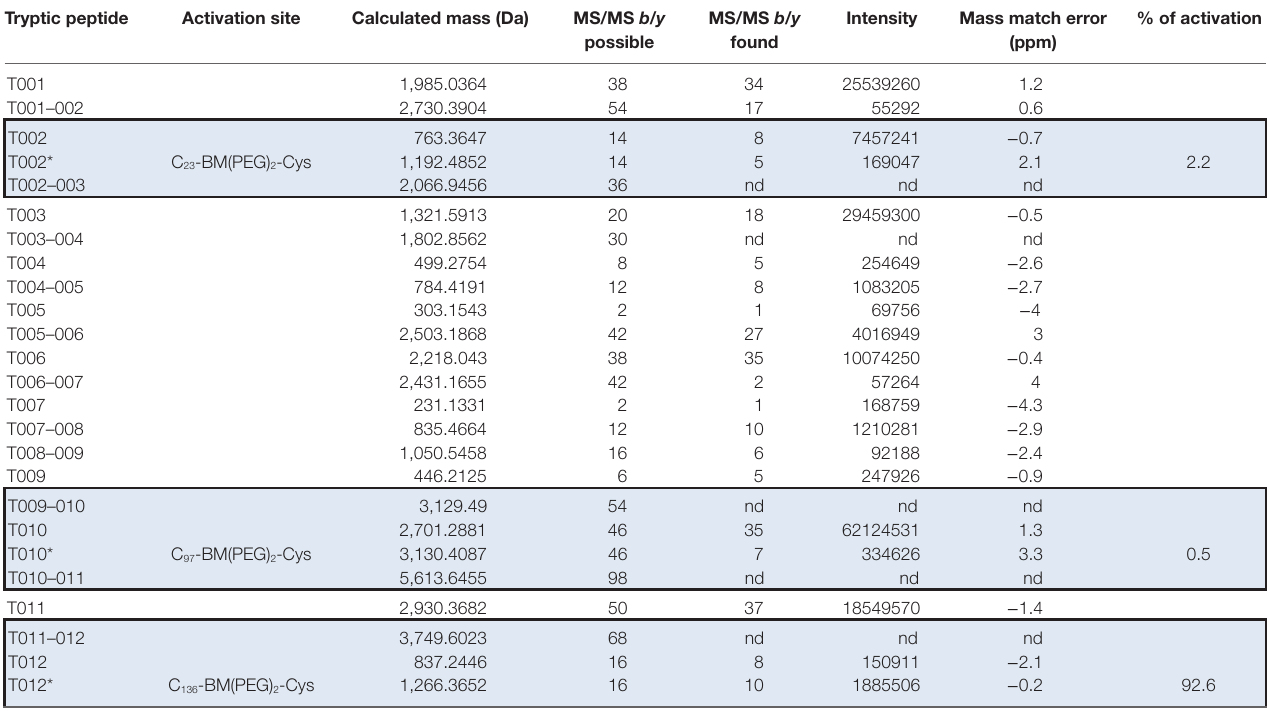
TaBle 2 | List of identified peptides and activation sites of V21H4-(PEG) 2 -Cys. Tryptic peptide